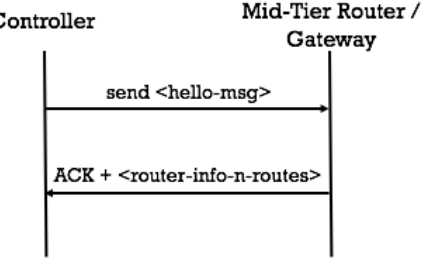
Figure 3. Illustration of SDN Discovery Protocol